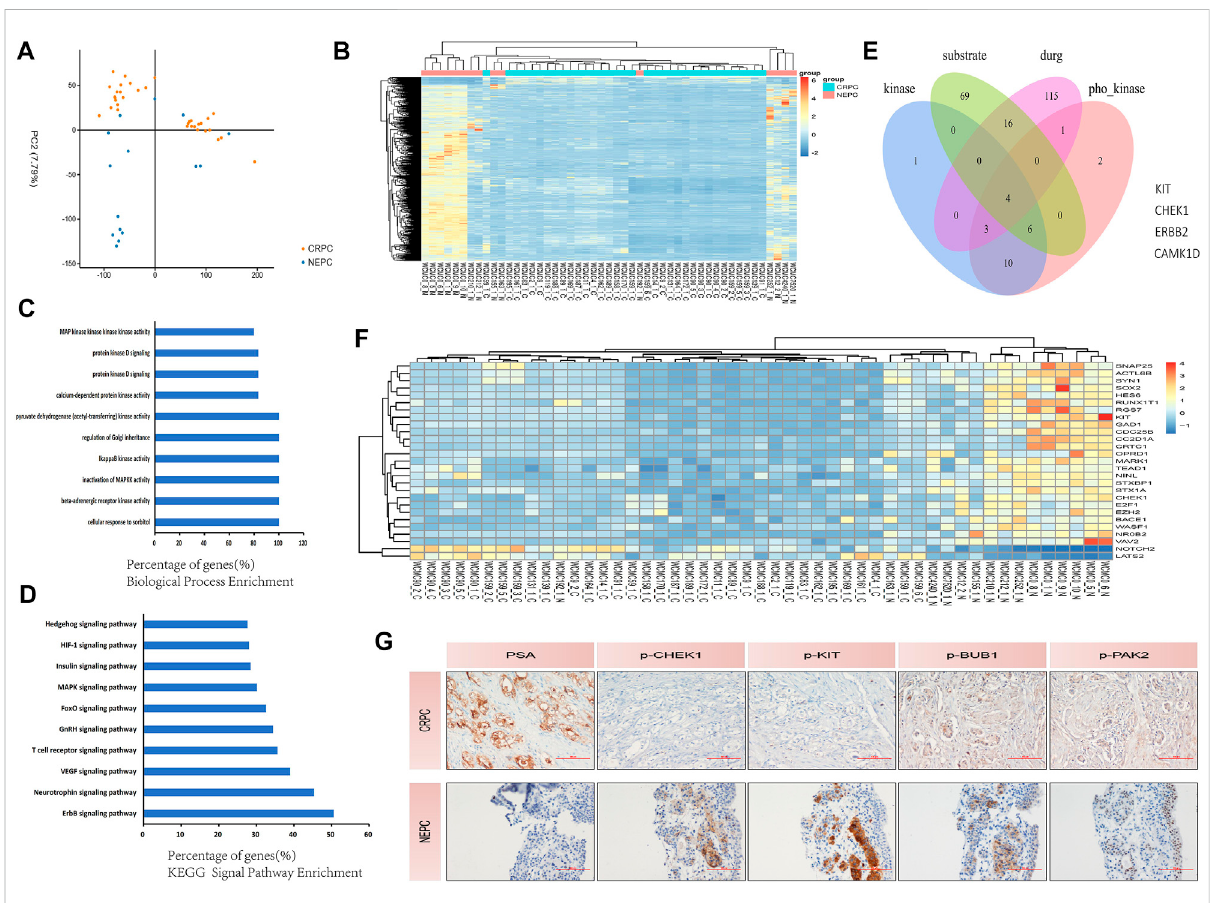
FIGURE 4 Protein kinases are involved in the development of NEPC. (A) PCA plot separated the PC tissues using expression data clustered into CRPC and NEPC (SCC of prostate). The blue, brown, and plots represent NEPC (SCC of prostate) and CRPC, respectively. (B) Hierarchical clustering of protein kinase differential expression pro fifi les among the CRPC group and NEPC (SCC of prostate) group in 49 samples. The heat maps are based on expression values of signi fifi cantly differentially expressed protein kinases ( p < 0.05) detected by microarray probes. ‘‘ Red ’’ and ‘‘ Blue ’’ indicate expression above and below, respectively, relative expression. (C) Biological process enrichment of the protein kinases. In biological process enrichment,proteinkinaseswereprimarilyassociatedwiththephosphatidylinositolmetabolicprocess, signaltransduction,theproteinmodi fi cation process, and protein phosphorylation. (D) KEGG pathway enrichment analyses demonstrate the signi fifi cance of protein kinases. Protein kinases were mainly associated with several signaling pathways that could affect PC progression in the analysis of KEGG ( p < 0.01). (E) Selected protein kinases with increasing expression, which were associated with phosphorylated kinase substrate and targeted drugs as indicated by Venn diagrams: four protein kinases were selected. (F) The heat map shows the increasing expression during NEPC transdifferentiation of the 27 selected phosphorylatedanddrug-targetedproteinkinases. ‘‘ Red ’’ and ‘‘ Blue ’’ indicateexpressionaboveandbelow,respectively,relativeexpression.Theheat maps are based on expression values of signi fifi cantly differentially expressed protein kinases ( p < 0.05) detected by microarray probes. (G) Immunohistochemical staining of the CRPC patient ’ s prostate tissue and the NEPC patient ’ s prostate tissue, including PSA, p-CHEK1, p-KIT, p-BUB1 and p-PAK2 indicators. NEPC, neuroendocrine prostate cancer; CRPC, castration-resistant prostate cancer; KEGG, Kyoto Encyclopedia of Genes and Genomes pathway; PCA, principle component analysis; PC, prostate cancer; SCC, small cell